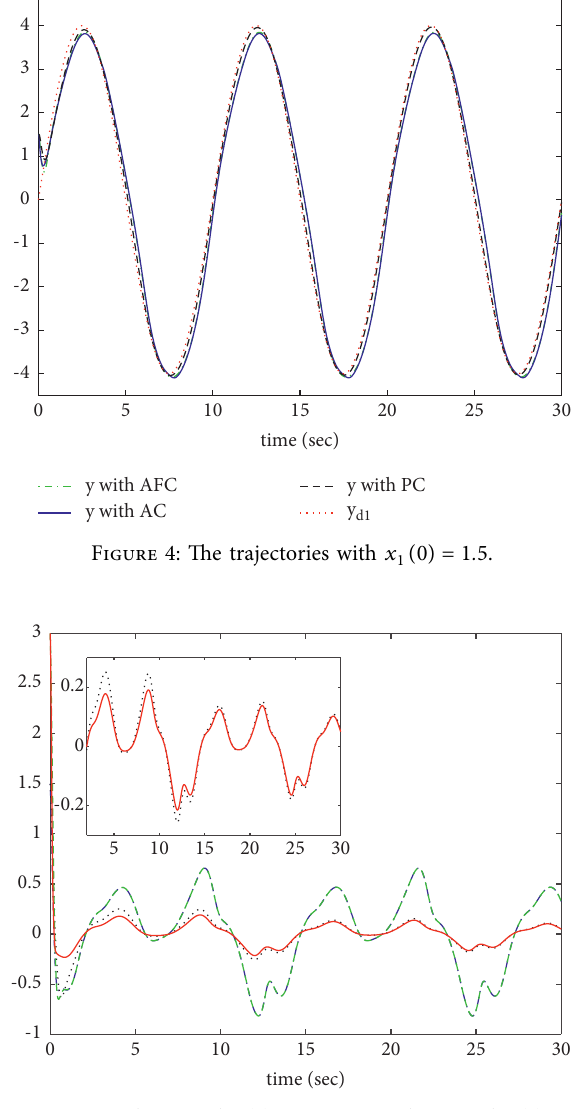
Figure 5: The comparison of tracking errors between PC and AFC with y